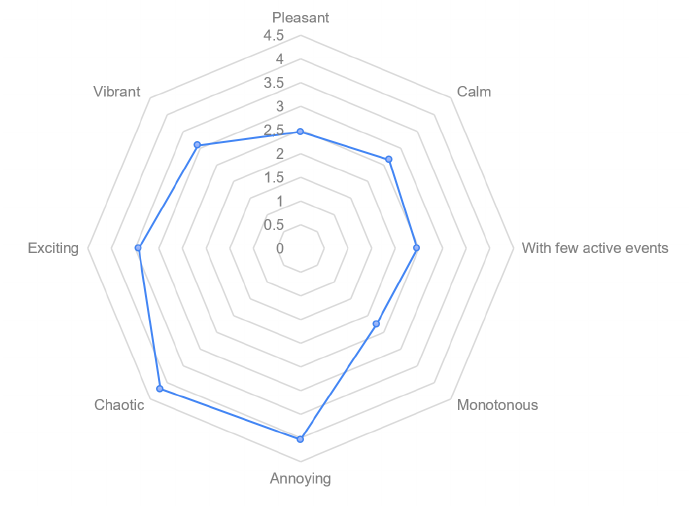
Figure 14. Survey with average response of perceived soundscape of the Water